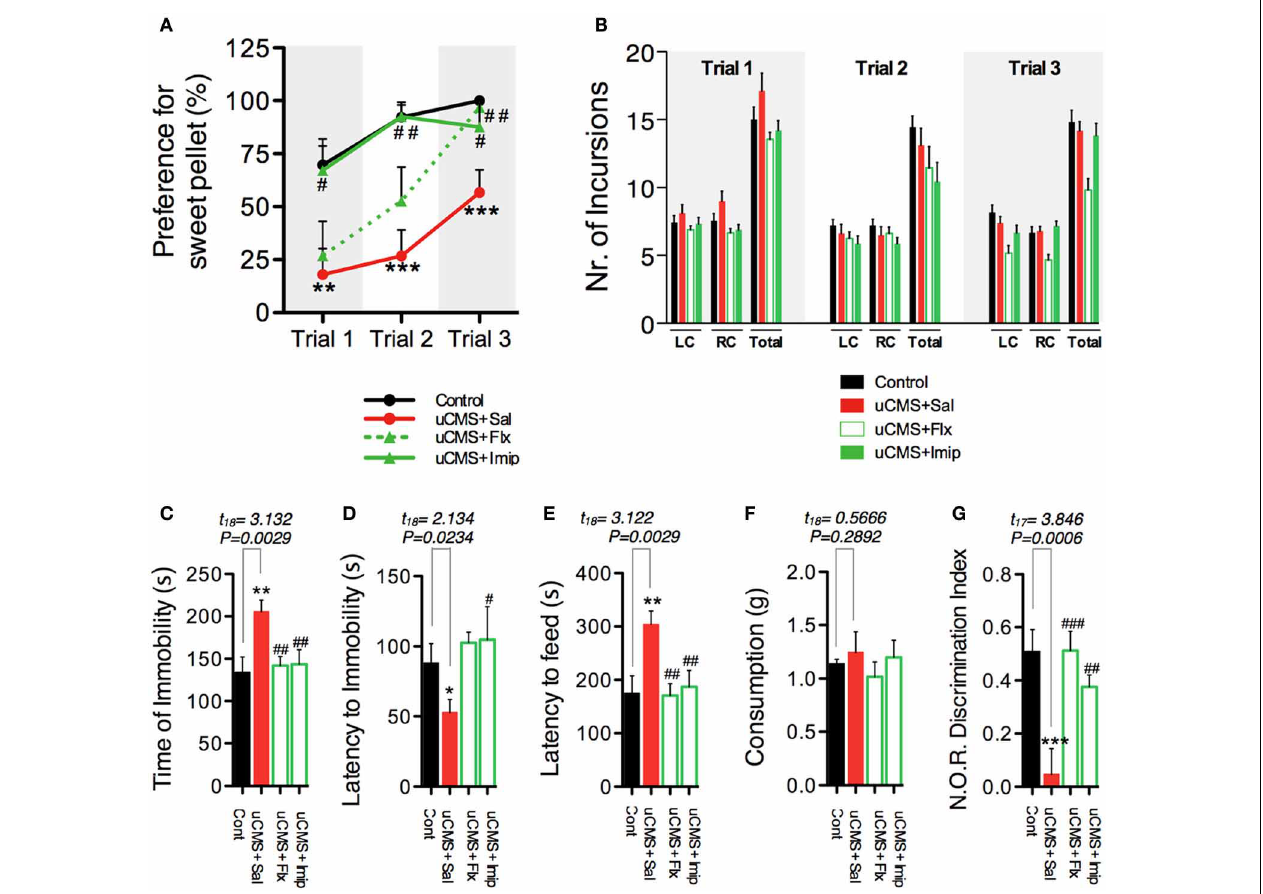
FIGURE 6 | Additional behavioral parameters determined after 6 weeks of uCMS exposure and ADs treatment. (A) uCMS exposure induced a significant decrease in preference for sweet pellets along the trials [Trial 1: t ( 18 ) = 3 . 011, P = 0 . 0038; Trial 2: t ( 18 ) = 4 . 795, P < 0 . 0001; Trial 3: t ( 18 ) = 4 . 007, P = 0 . 0004]. This anhedonic profile was effectively reversed by imipramine in the three trials, while the improving effects of fluoxetine were mainly observed in trial 3 [Trial 1: F ( 2 , 27 ) = 3 . 784, P = 0 . 0356, Post-hoc : P uCMS vs . uCMS + Flx > 0 . 05, P uCMS vs . uCMS + Imip < 0 . 05; Trial 2: F ( 2 , 27 ) = 7 . 176, P = 0 . 0032, Post-hoc : P uCMS vs . uCMS + Flx > 0 . 05, P uCMS vs . uCMS + Imip < 0 . 01; Trial 3: F ( 2 , 27 ) = 5 . 427, P = 0 . 0104, Post-hoc : P uCMS vs . uCMS + Flx < 0 . 01, P uCMS vs . uCMS + Imip < 0 . 05]. (B) The average number of incursions into the left-chamber (LC; containing sweet pellets) and into the right-chamber (RC; containing regular pellets), during SDT was assessed and no significant differences were found. (C–G) Emotional and